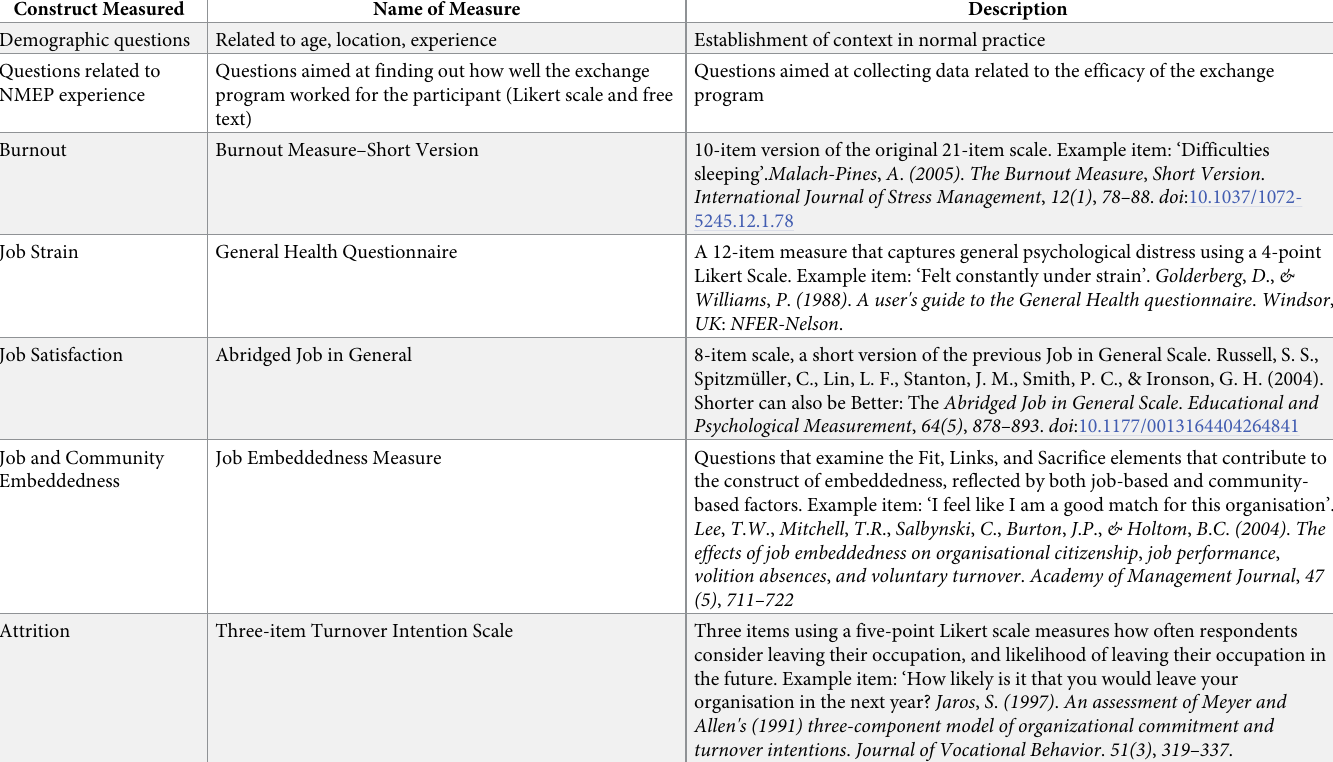
Table 1. Questionnaire used in the